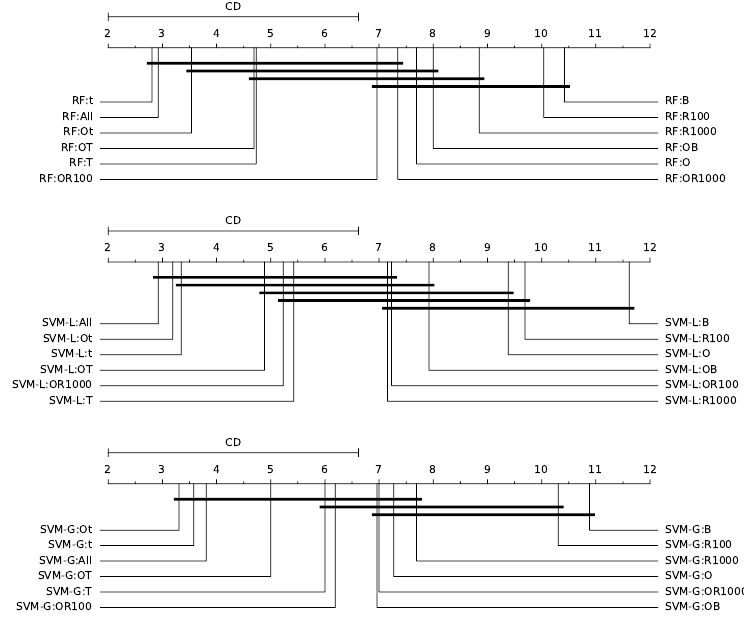
Figure 9. Critical difference diagrams for the Nemenyi test, for the difficult datasets ( α =